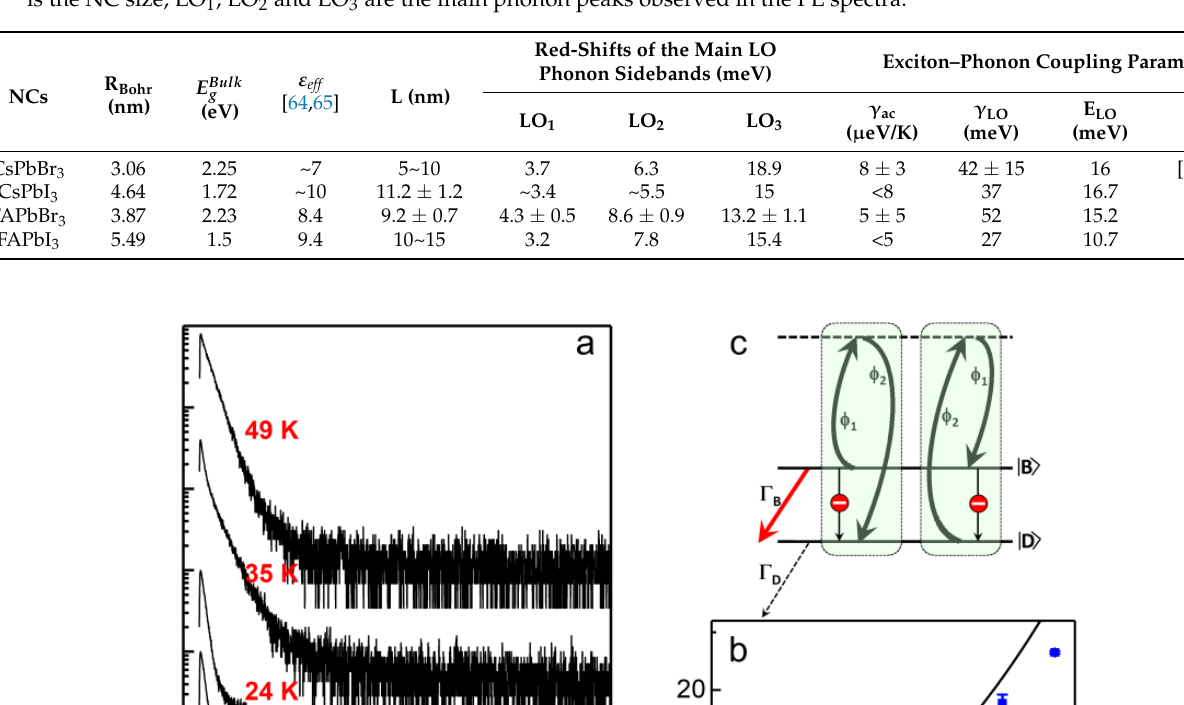
Table 1. Energies of the three main LO phonon replicas and exciton–phonon coupling parameters of several lead halide perovskite NCs. R Bohr is the exciton Bohr radius; E Bulk g is the bulk bandgap energy; ε eff is the effective dielectric constant; L is the NC size; LO 1 , LO 2 and LO 3 are the main phonon peaks observed in the PL spectra.